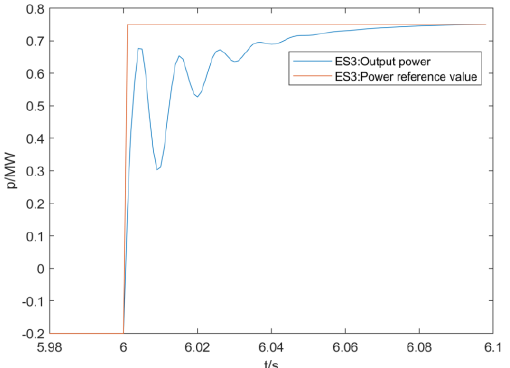
Figure 18. Response characteristic of discharge power of